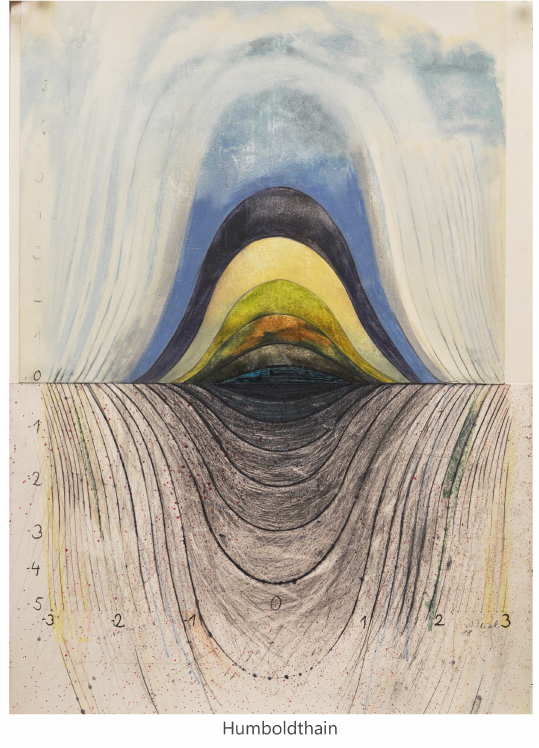
Figure 3. ( p , q ) -circles for ( p , q ) = ( 2,0.6 ) and several values of r ( Humboldt Hain , Oil and pencil on prepared paper, 42 × 30).